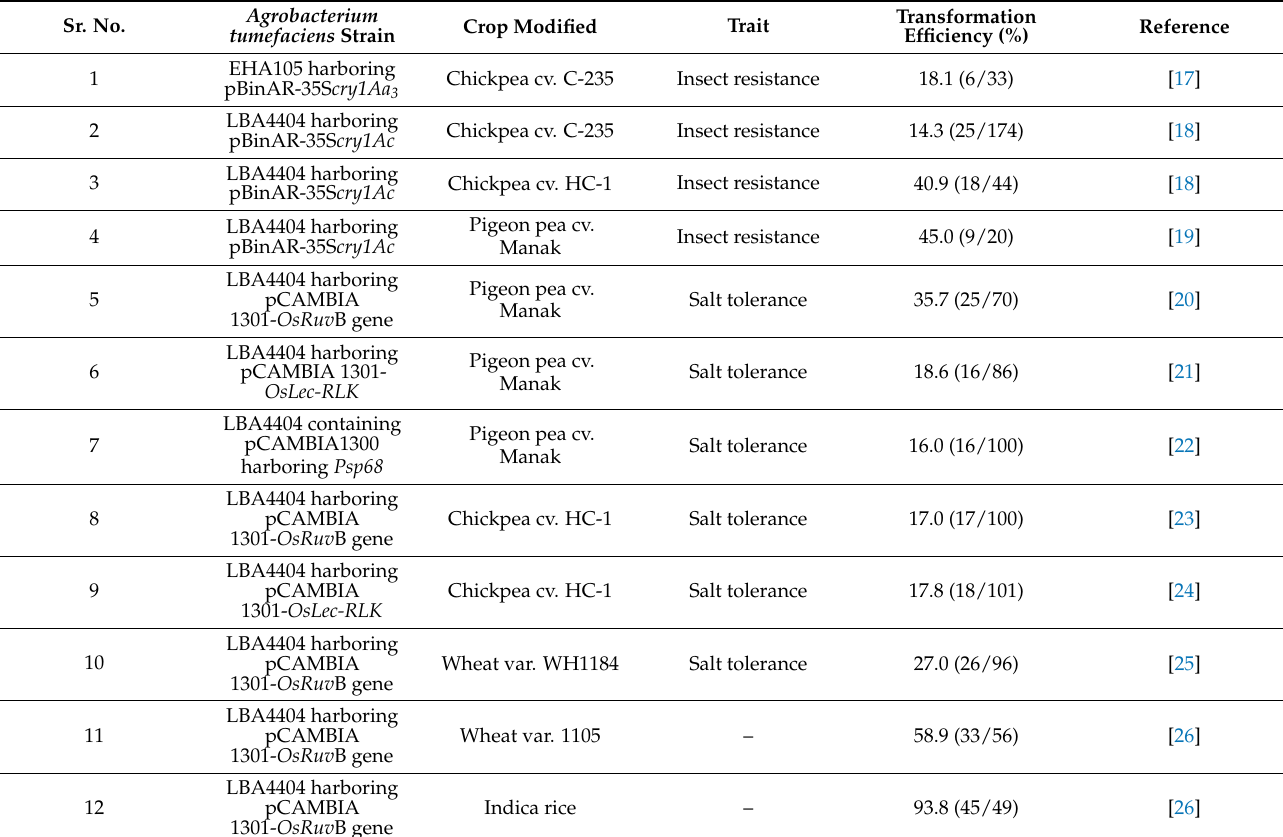
Table 2. Details of transformation experiments conducted using the reported